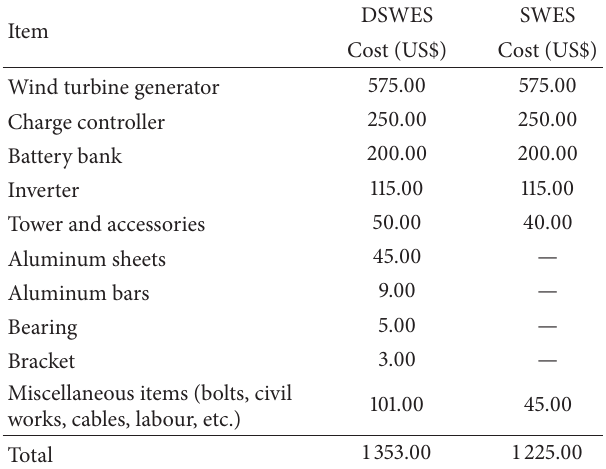
Table 1: Materials and corresponding costs for the DSWES and